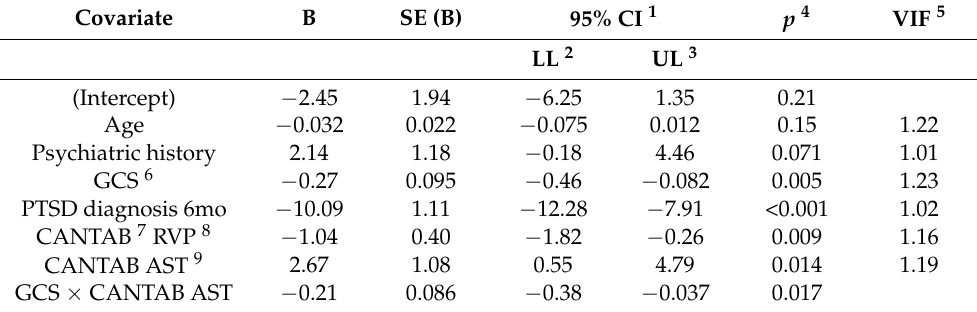
Table 2. Linear regression: covariates associated with PCL-5 change